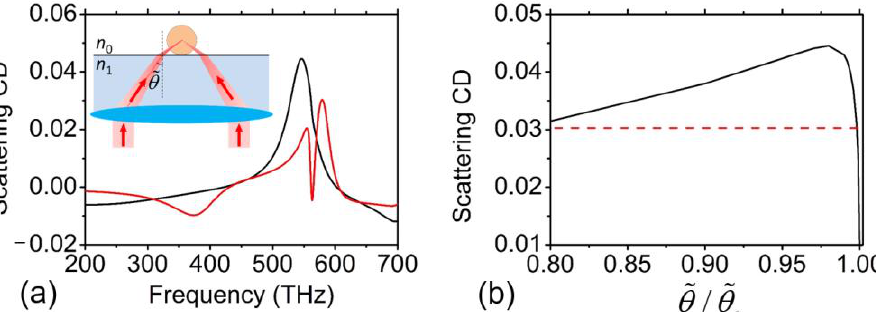
Figure 4. ( a ) The black curve represents the scattering CD spectrum of a chiral sphere on the substrate under the illumination of the superchiral field with (cid:101) θ = 0.98 (cid:101) θ c . The red curve is the scattering CD spectrum of the chiral sphere in free space excited by CPL. ( b ) The peak value of the scattering CD spectra with a different value of (cid:101) θ . The red dash line represents the peak value of the scattering CD spectra under the illumination of CPL, when the sphere is in free space.